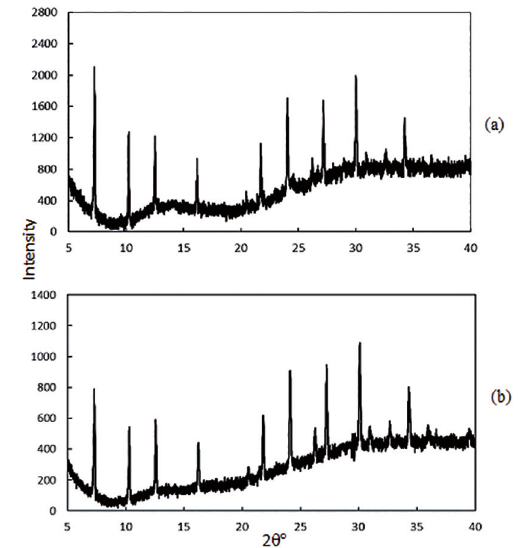
Figure 5: XRD patterns of the coatings prepared by substrate heating method from composition C a) after 4.5 h of synthesis primary at water bath and heating resistance temperatures of 75 0 C and 140 0C, respectively and b) after 16 h of synthesis at water bath and heating resistance temperatures of 30 0 C and 140 0 C, respectively.